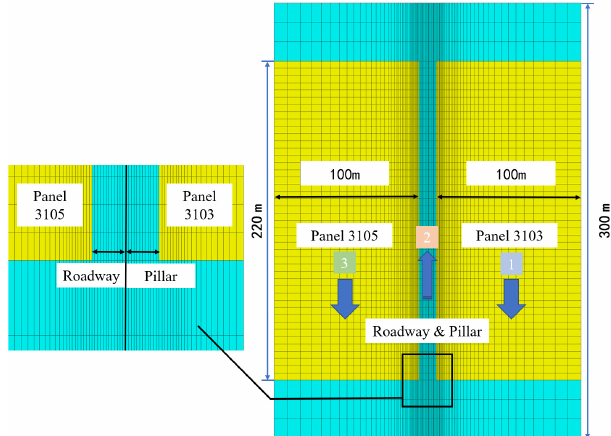
Figure 3. Plan view of numerical simulation of yield pillars goaf-side entry.